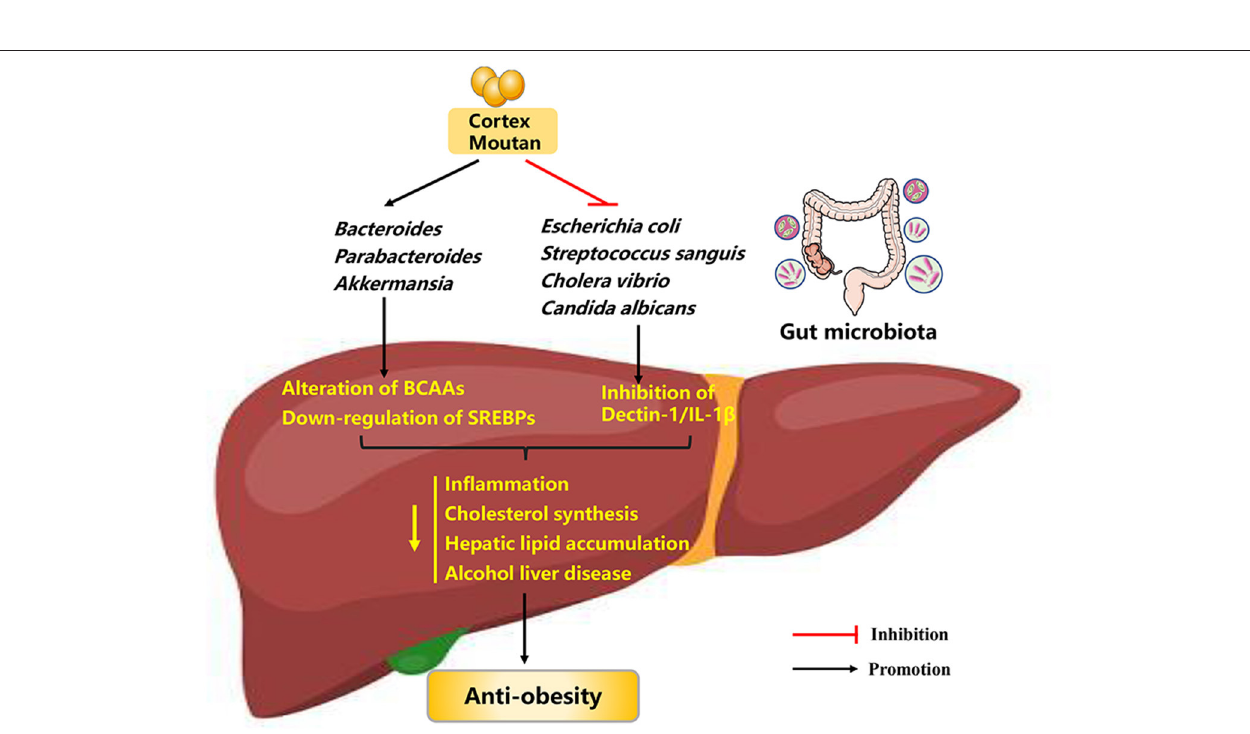
FIGURE 3 | Possible mechanisms explaining the anti-obesity effects of cortex moutan. BCAAs, branched-chain amino acids; SREBPs, sterol-regulatory element binding proteins; IL-1 β , interleukin-1 β .